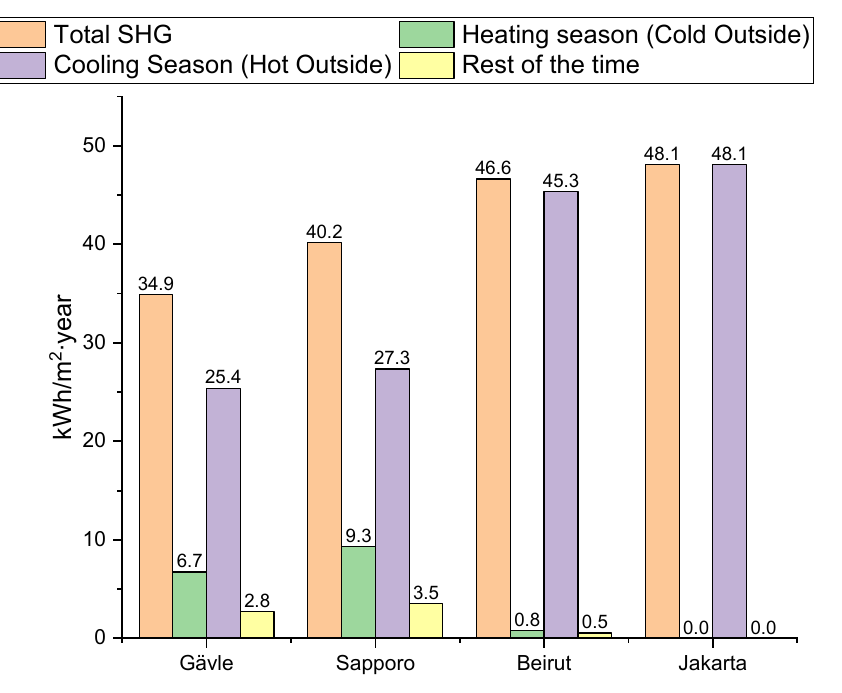
Figure 13. Thermal comfort main indicators as well as SDEIs for B0–B4 in Gävle.